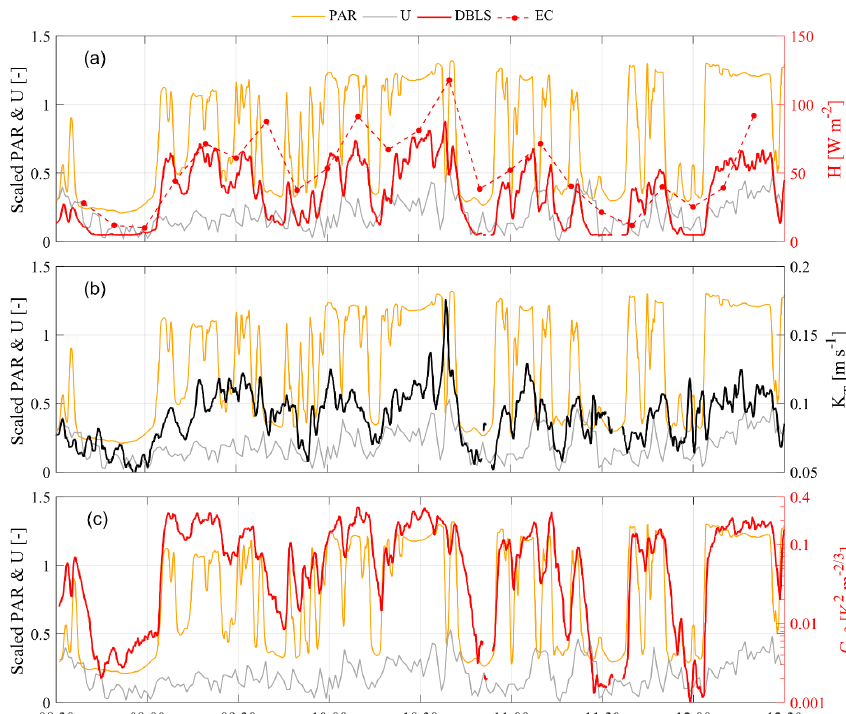
Figure 11. IOP 2 (15 June 2018) time series of (a) sensible heat flux ( H ) at 1min intervals with a displaced-beam laser scintillometer (DBLS) and at 10min intervals with an eddy covariance system (EC), combined with scaled time series of photosynthetically active radiation (PAR, scaled by 1500µmolm − 2 s − 1 ) and wind speed ( U , scaled by 6ms − 1 ); (b) turbulent exchange coefficient K T ; and (c) structure parameter of temperature, C 2 , that together make up H in the DBLS method following Eq. T